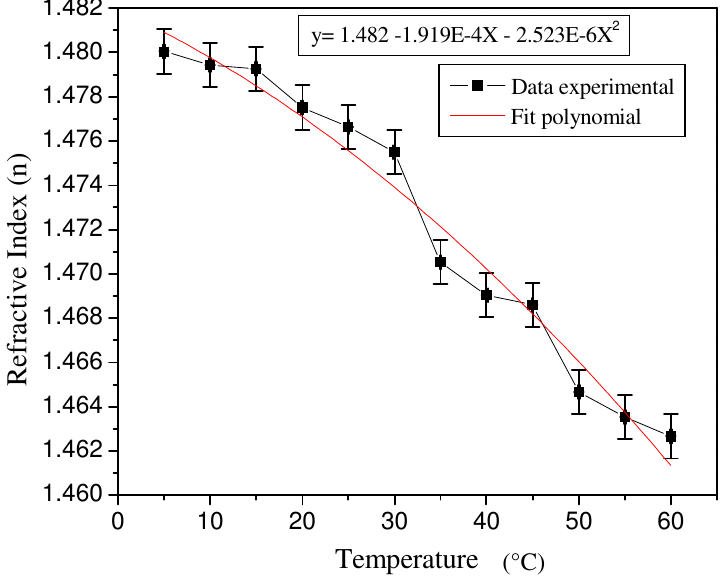
Figure 1. Refractive index of liquid corn syrup as a function of